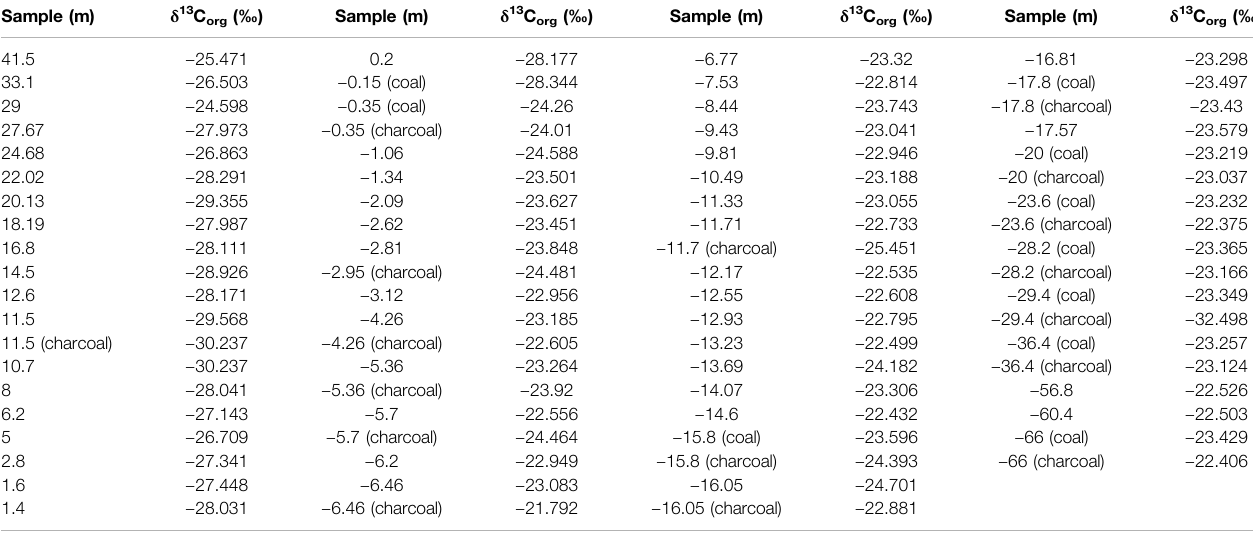
TABLE 1 | δ 13 C org data of bulk rocks, coals and charcoals from the Lengqinggou section in Guizhou Province, Southwest China. Sample (m)